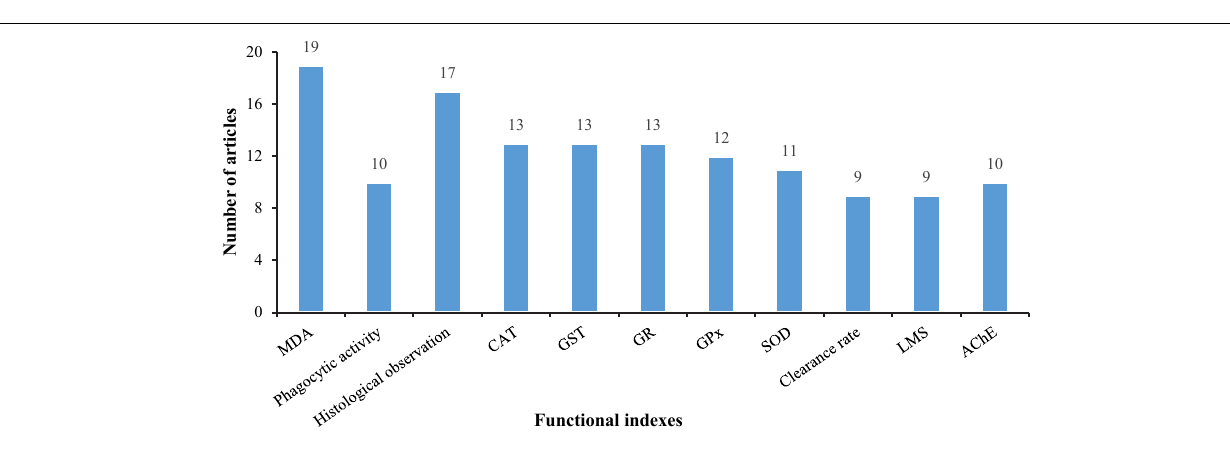
FIGURE 6 | The number of articles on functional responses in mollusks exposed to microplastics.